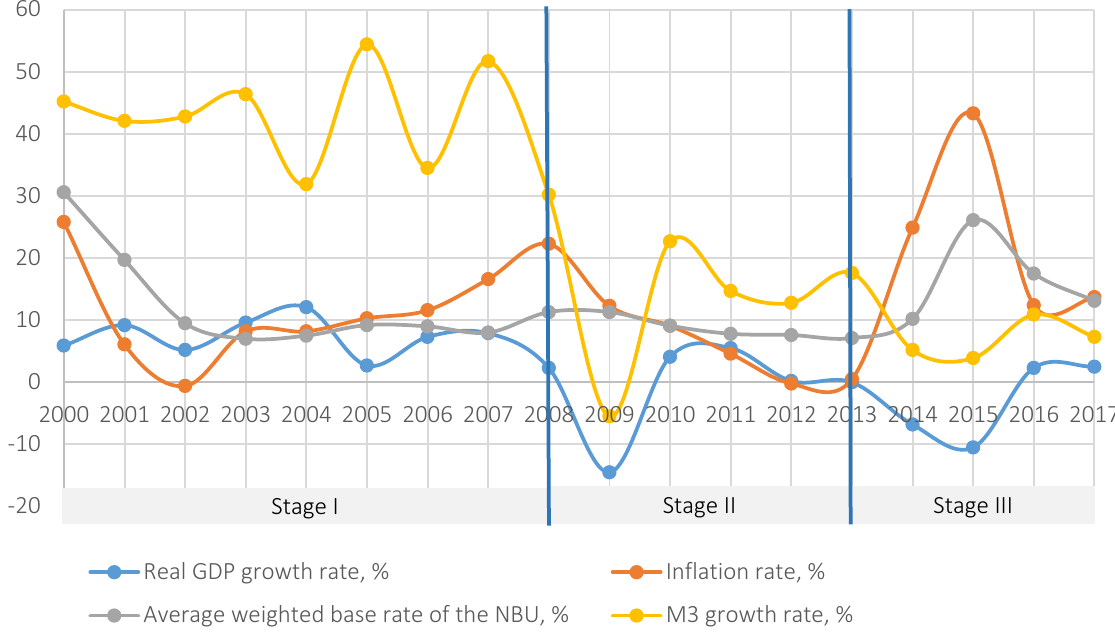
Figure 1. Graphic presentation of the real GDP growth rate and the